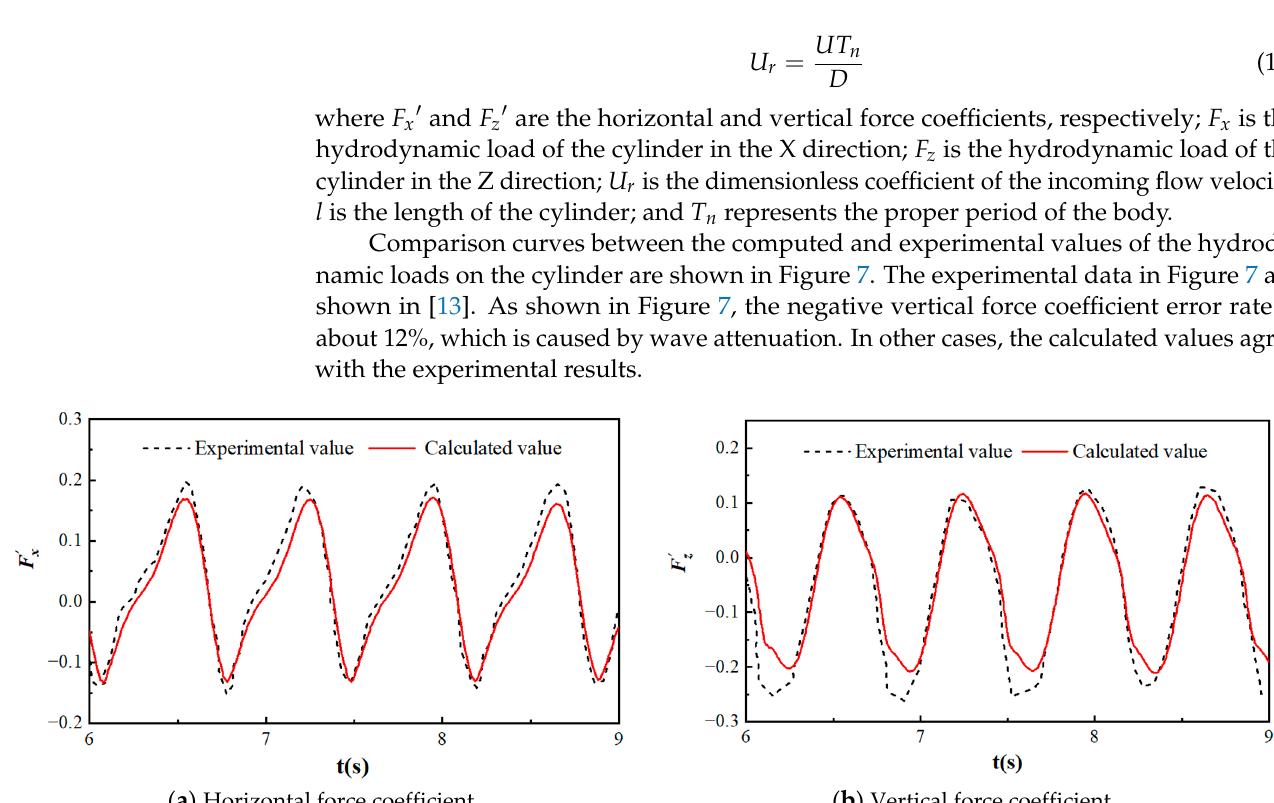
Figure 7. Comparison between calculated and experimental values.